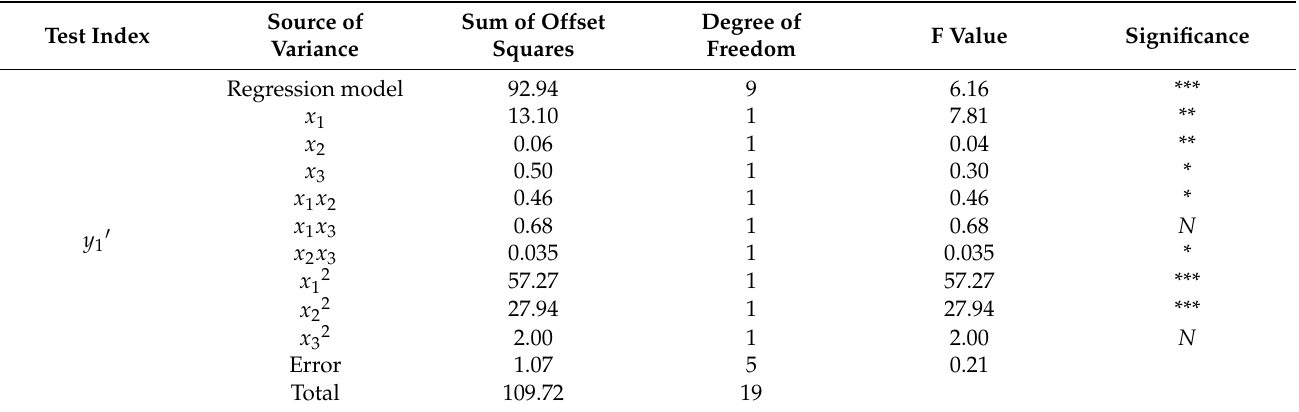
Table 5. Analysis of variance of each factor on the test